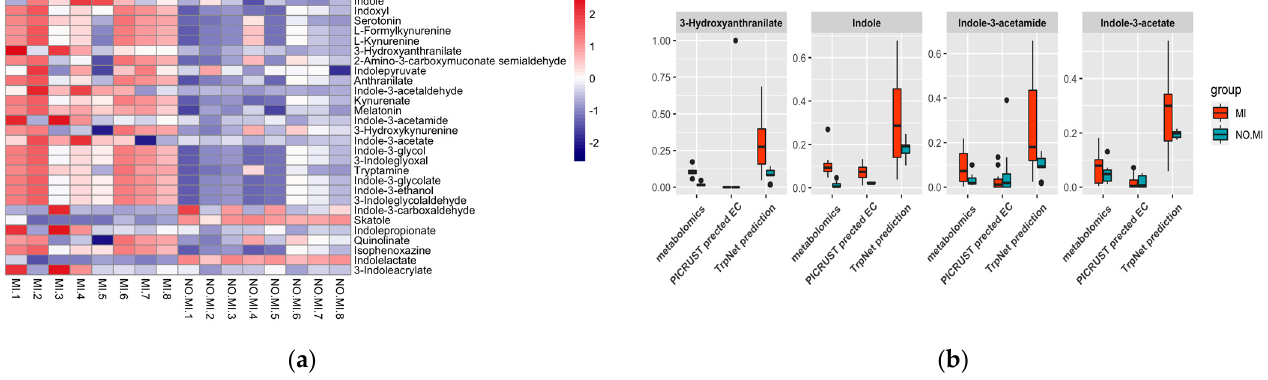
Figure 7. ( a ) Tryptophan metabolite prediction from microbiome data; ( b ) TrpNet prediction com- pared with metabolomics data and PICRUSt prediction.